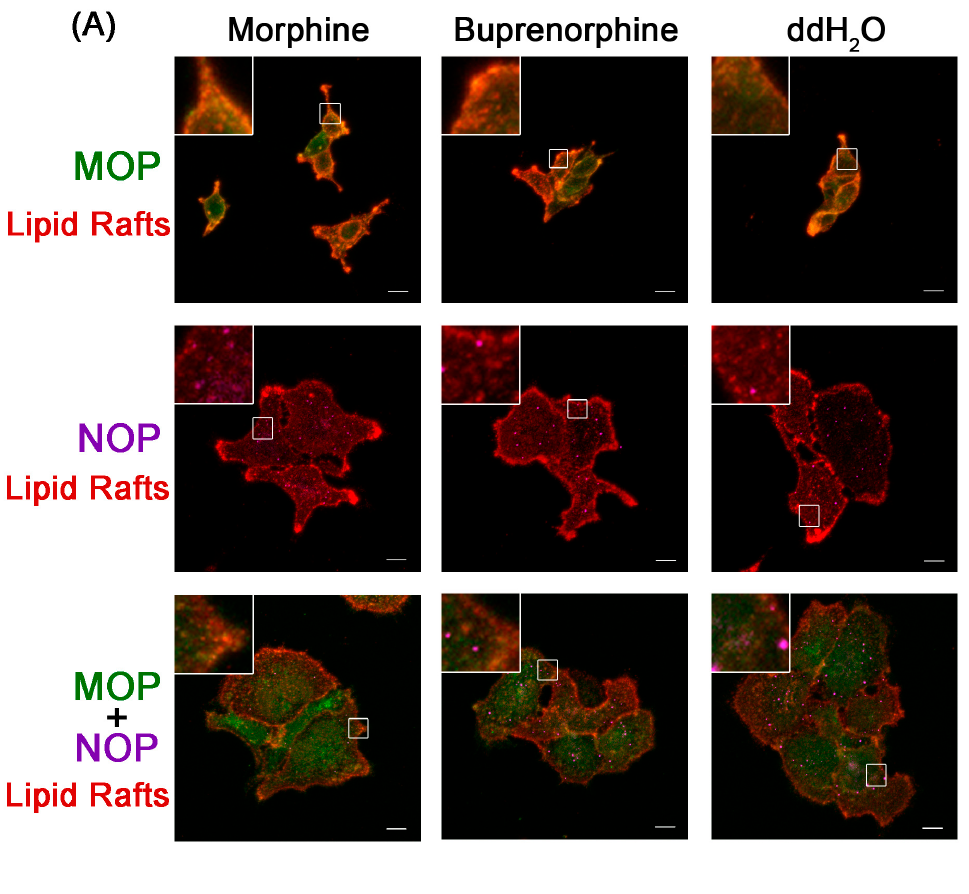
Figure 3. Representative confocal images ( A ) and colocalization rates of MOP and NOP on lipid rafts (red) ( B ) from HEK 293 cells stably expressing HA-tagged MOP (green) and/or myc-tagged NOP (magenta) after exposure to morphine (1 μ M) or buprenorphine (1 μ M) for 20 min at 4 °C. The inset panels display higher magnification images highlighting the colocalization. Scale bars are equal to 10 μ m. Each bar represents the mean ± SE value of the percentage of ROI colocalization derived from five independent experiments with 4–6 individual cell images in each group.